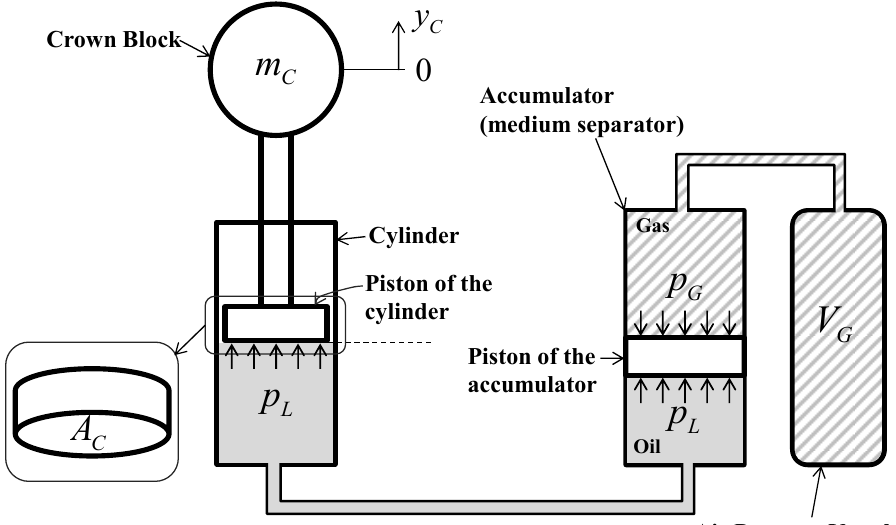
Figure 10. Simplified pneumatic and hydraulic control model.